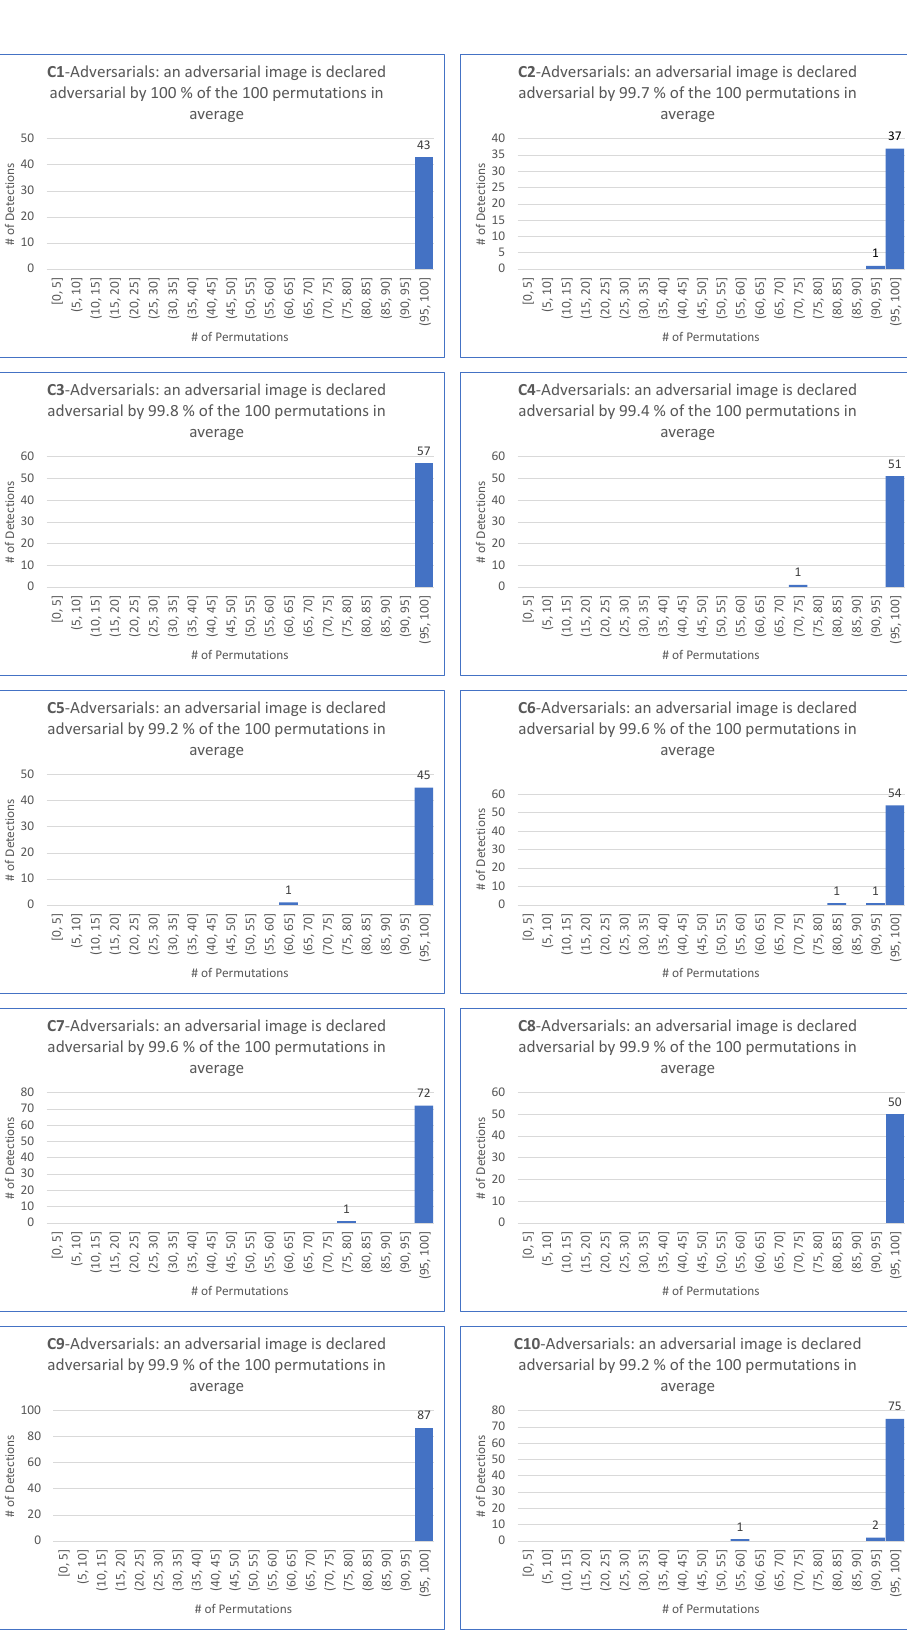
Figure A4. ShuffleDetect results for adversarial images generated by the BIM-targeted attack on C = C for 1 ≤ k ≤ 10 over 100